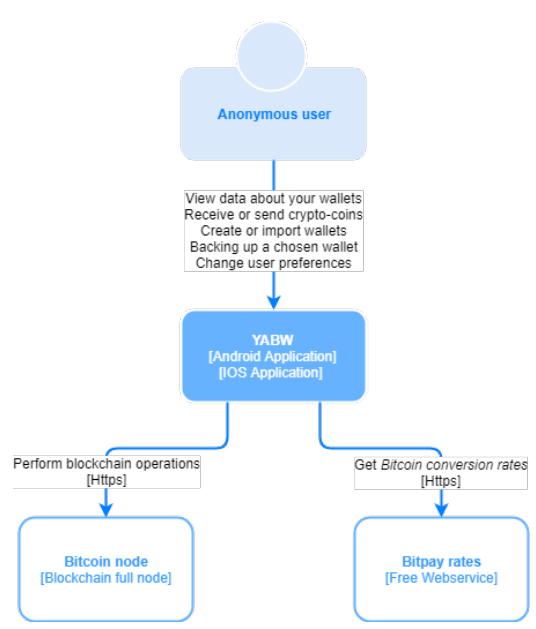
Figure 1. System context diagram [C4–Level 1].